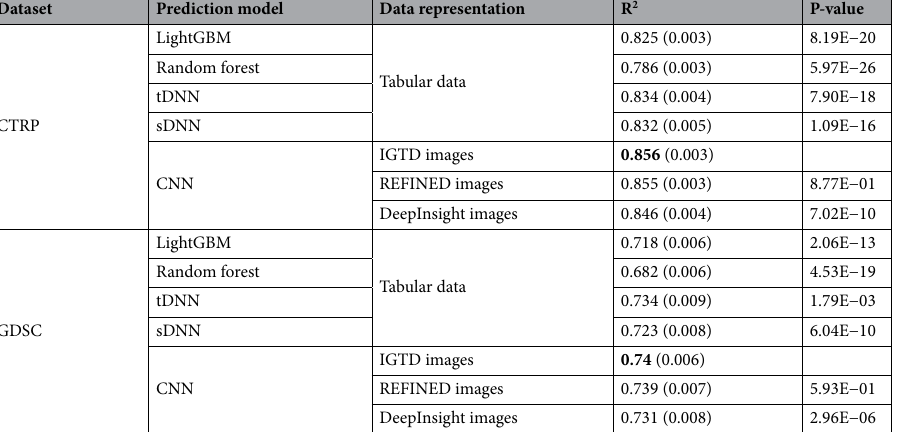
Table 2. Comparison on the drug response prediction performance of different data representations and prediction models. In the R 2 column, the number before parenthesis is the average R 2 across 20 cross- validation trials, and the number in the parenthesis is the standard deviation. Bold indicates the highest average R 2 obtained on each dataset. P-value is obtained via the two-tail pairwise t-test to compare the performance of CNNs trained on IGTD images with those of other combinations of prediction models and data representations.